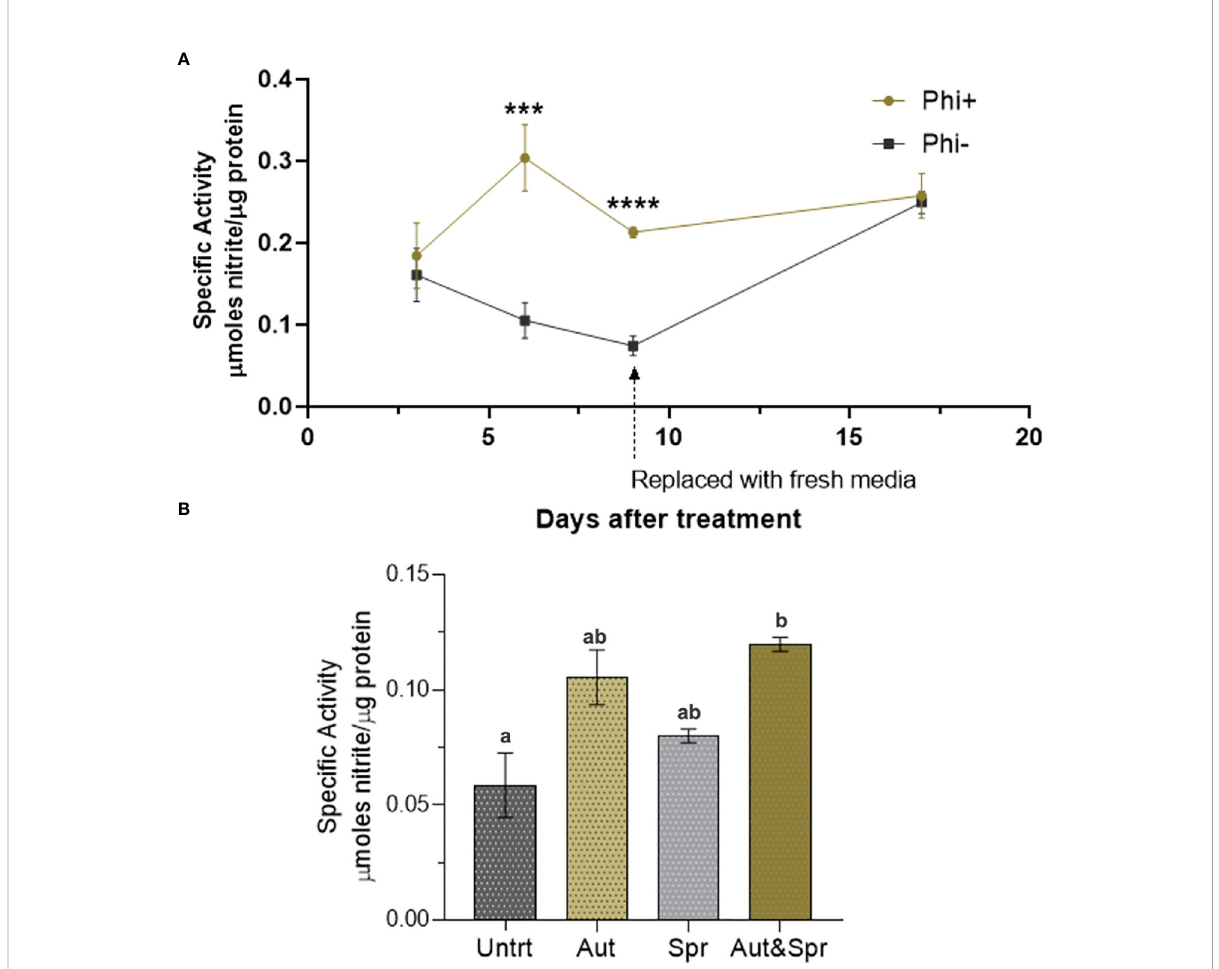
FIGURE 6 Phosphite enhances Nitrate Reductase activity. (A) Time-course assessment of NR activity of wheat plants grown under reduced nutrient (50% strength) from 3 days to 19 days post treatment. *indicates signi fi cant difference. (***P ≤ 0.001 and ****P ≤ 0.0001; student's t test) (B) . Wheat plants grown in the fi eld with different times of phosphite application. Effect of phosphite on nitrate reductase activity is commonly observed under mild stress. All values are means ± SE (n= 5 - 25); Different letters denote statistical signi fi cance (P ≤ 0.05; one-way analysis of variances. All values are means ± SE (n= 5 - 25) for both (A, B)